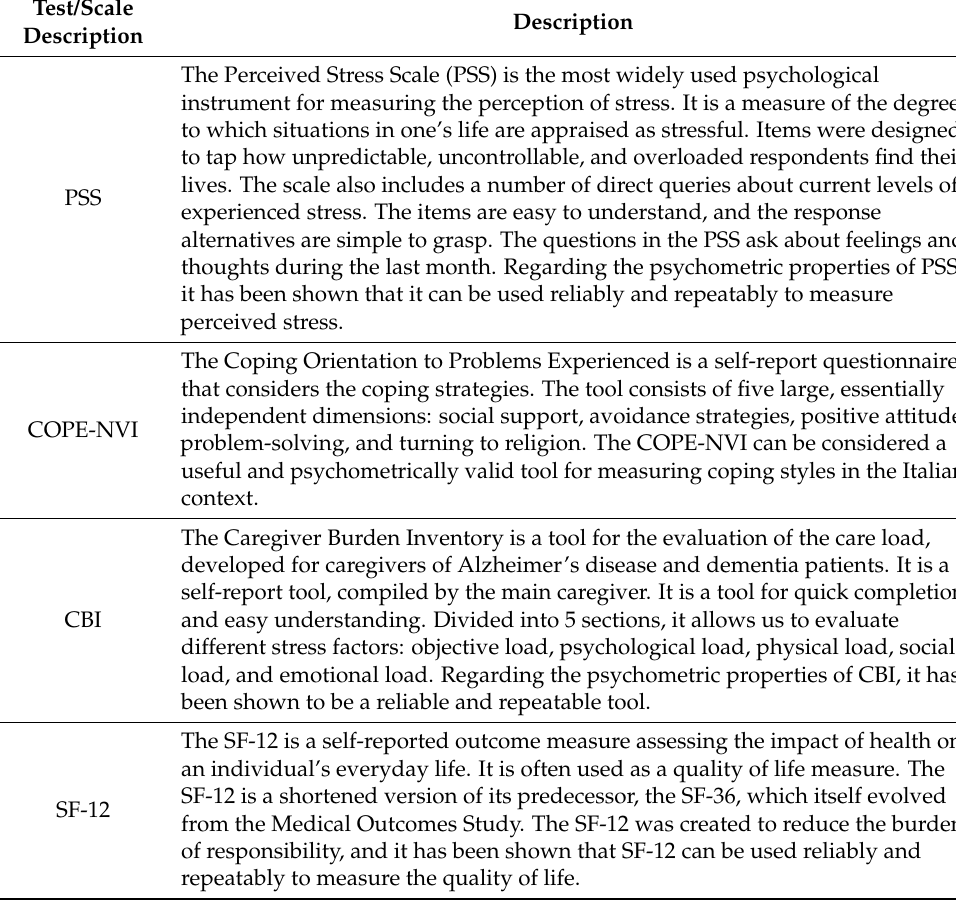
Table 2. Clinical assessment